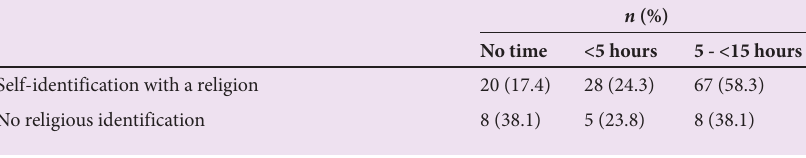
Table 5. Self-identification v. time for education in religion